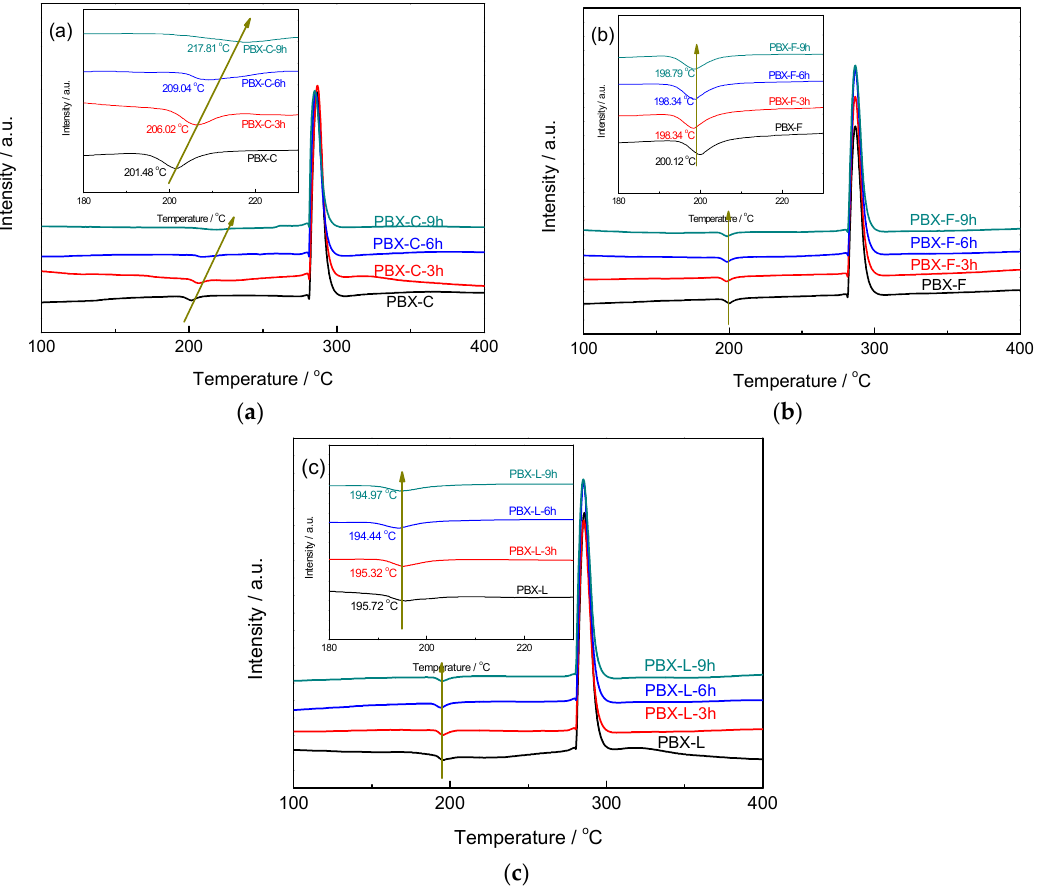
Figure 6. DSC curves of PDA modified PBXs: ( a ) PDA modified PBX-C, ( b ) PDA modified PBX-F, ( c ) PDA modified PBX-L.